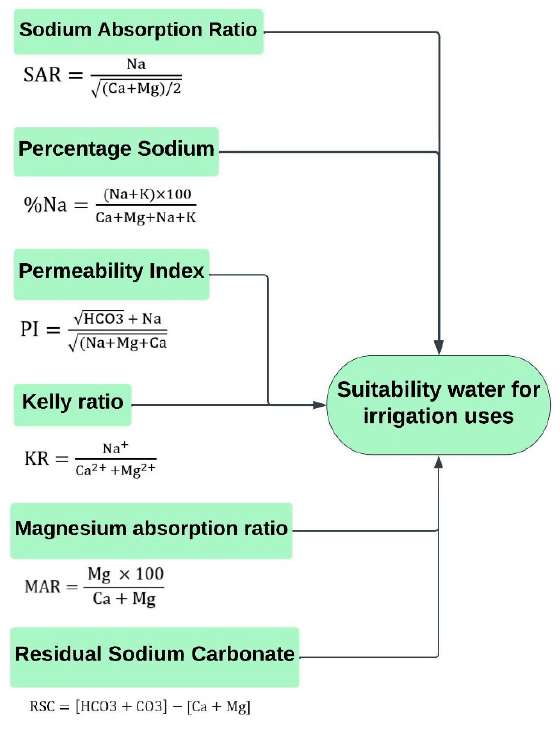
Figure 4. Irrigation indices methodology.